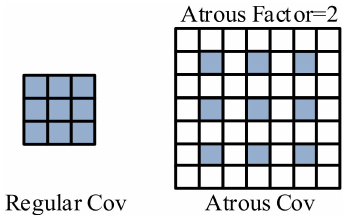
Figure 4. Illustration of atrous